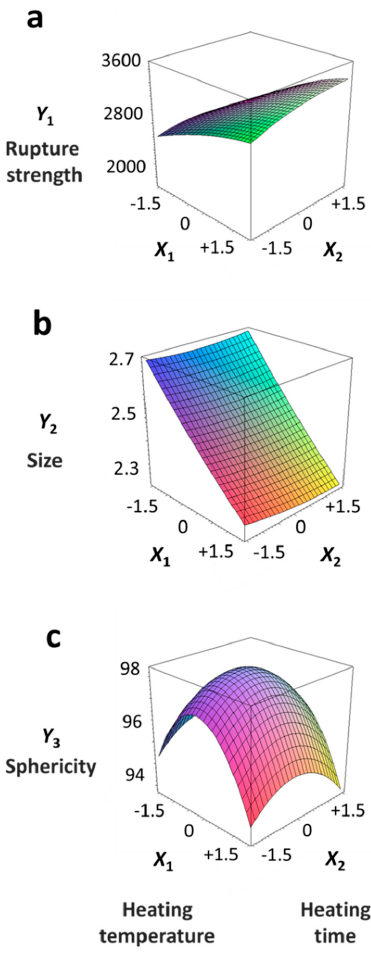
Figure 2. Three ‐ dimensional response surface plots for rupture strength ( a ), size ( b ), and sphericity ( c ). X 1 ; Heating temperature (°C), X 2 ; Heating time